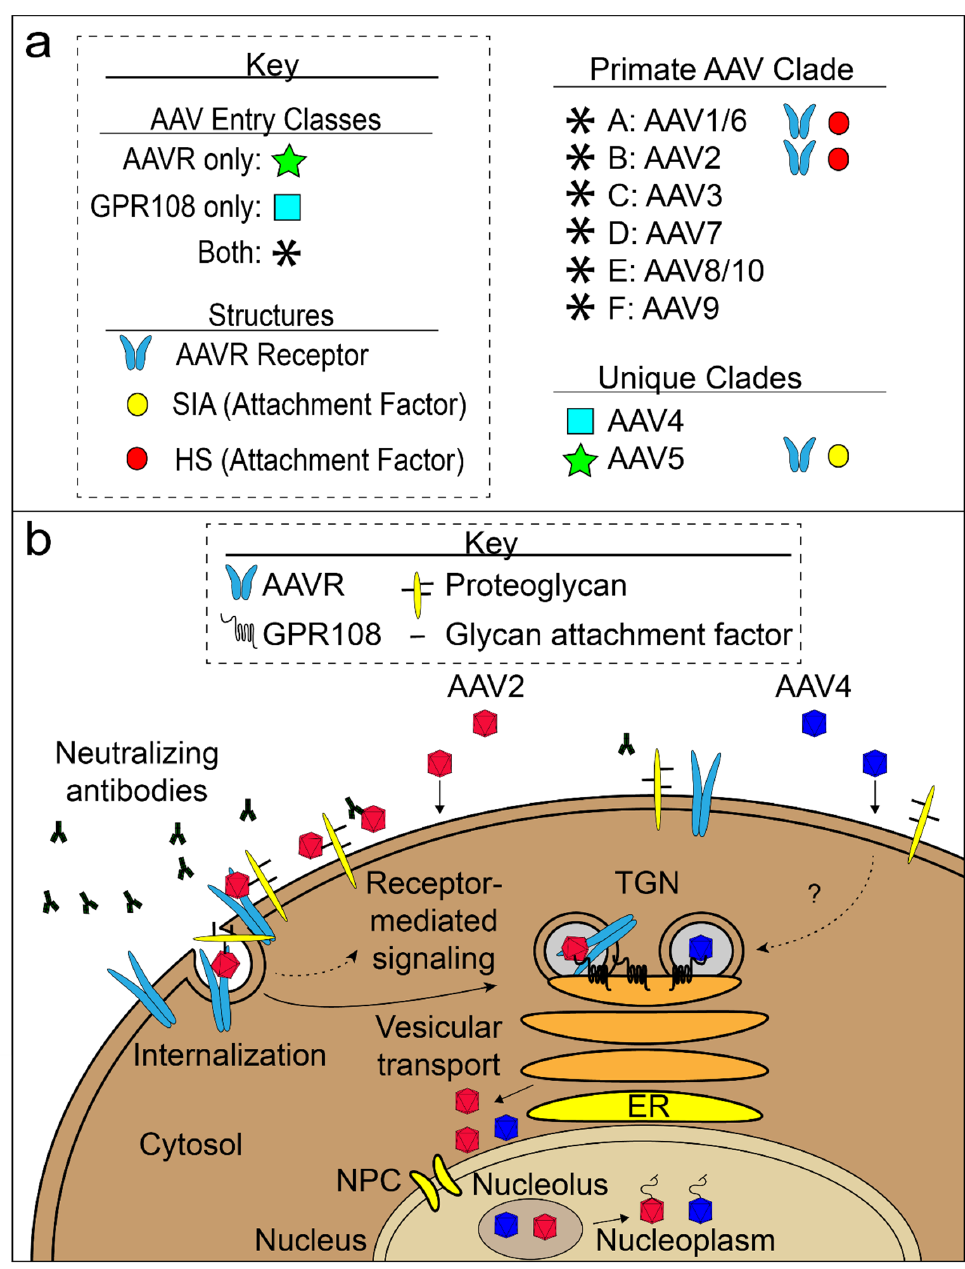
Figure 5. AAV entry model. ( a ) Three known AAV entry classes are shown: AAVR-dependent (green star), GPR108-dependent (light blue box) and both AAVR and GPR108-dependent (black asterisk). Structures for AAV complexes with glycan attachment factors (yellow and red circles) and AAV:AAVR complexes (light blue receptor icon) are known. Appropriate AAV entry class icons are located to the left of AAV serotypes and structural icons are located to the right of AAV serotypes with structural evidence. ( b ) AAV cell attachment, entry, and trafficking to the nucleus of a non-polarized cell. Two AAV classes are shown: AAVR/GPR108-dependent (red; majority of AAVs), represented by AAV2, and GPR108- dependent/AAVR-independent (blue; AAV4 clade). Virions must evade host neutralizing antibodies (black antibody-shaped icons). AAV virions (red or blue) come into contact with the cell surface and attach to the glycan moieties of proteoglycans. Red AAV binds to the AAVR receptor and is internalized and transported through the trans-Golgi network (TGN). Blue, GPR108-dependent, AAV particles enter through a parallel but possibly distinct pathway. Virions accumulate outside of the nucleus before entry and may involve the nuclear pore complex (NPC). AAV gathers in the nucleolus prior to being extruded into the nucleoplasm where the ssDNA genome is released.